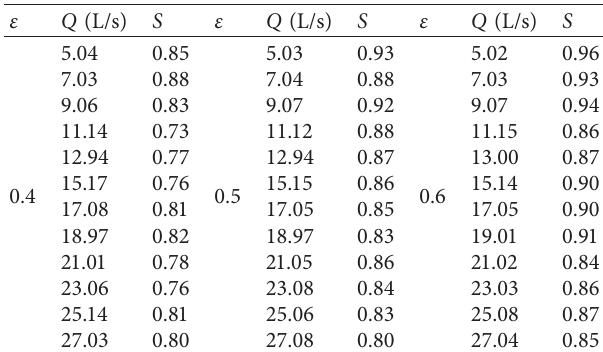
Figure 9: The Froude number at different contraction ratios and discharge rates in Section 1. Table 4: Submergence limits at different contraction ratios and discharge